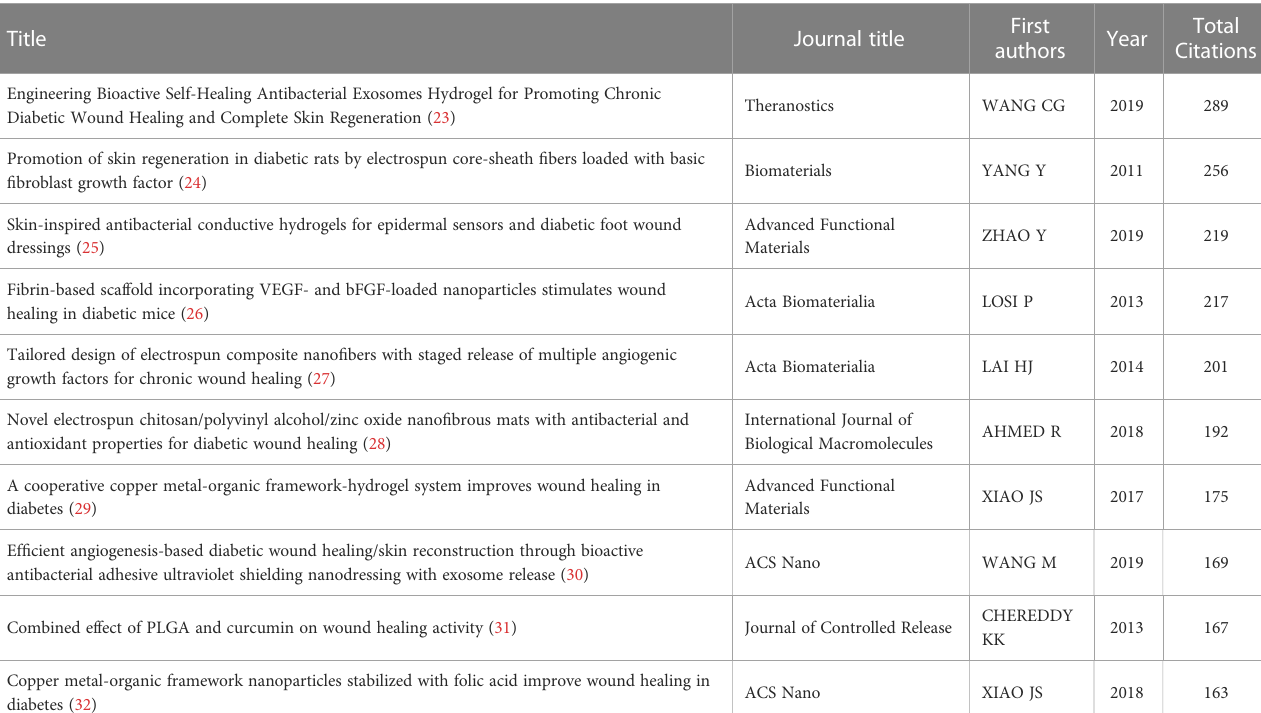
TABLE 5 Top 10 global cited articles in nanomaterials and diabetic wound healing.